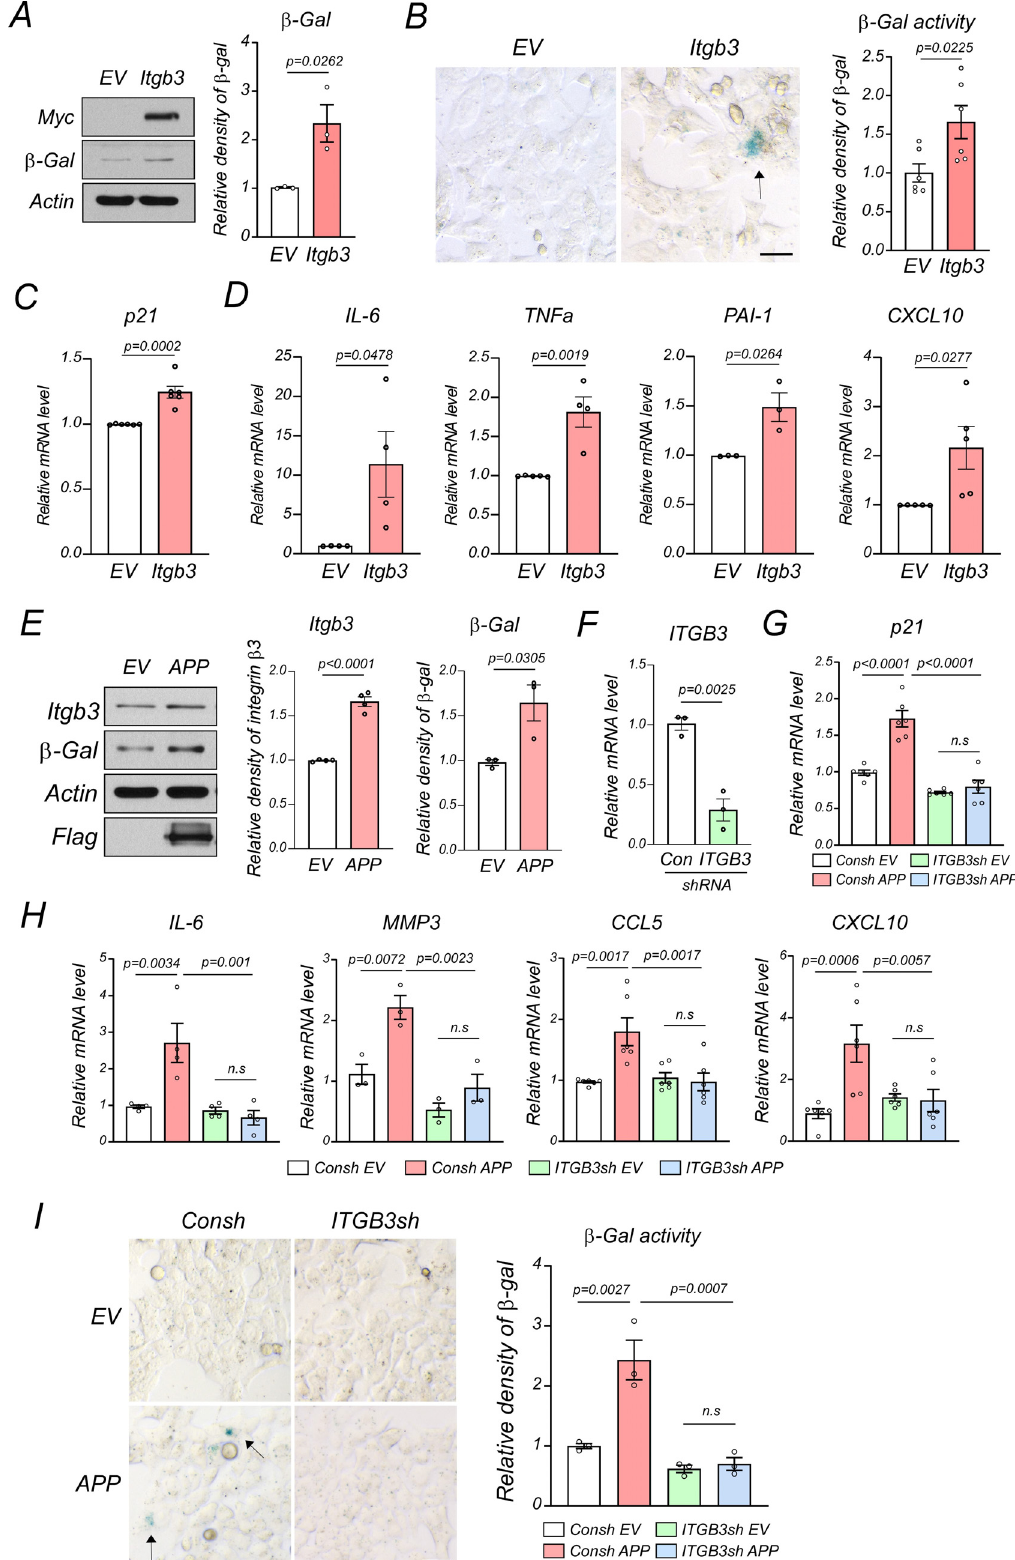
Figure 6. Integrin β 3 mediates APP-induced colonic senescence. ( A ) Total protein lysates were harvested from HCT116 cells overexpressing an empty Myc vector (EV) or a Myc-tagged integrin β 3 (Itgb3) vector and subjected to western blotting. Representative immunoblots of three independent experiments are shown. Relative β -galactosidase ( β -gal) density was quantified. ( B ) Senescence as- sociated β -galactosidase (SA- β -gal) activity was assessed after 48-h overexpression of EV or the